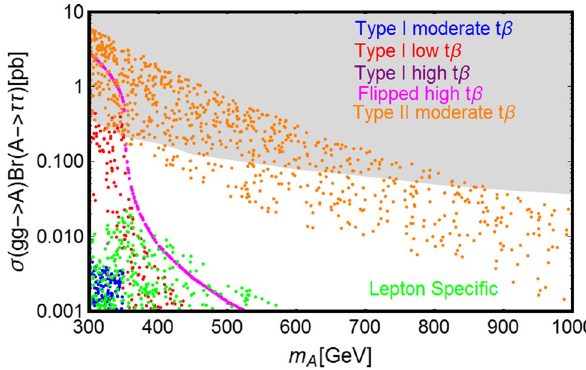
Fig. 14 Production cross section for the process pp → ¯ ττ for the set of models with viable relic density. The colors distinguish the type of 2HDM realizations. The gray region is excluded by current limits [87, 88]